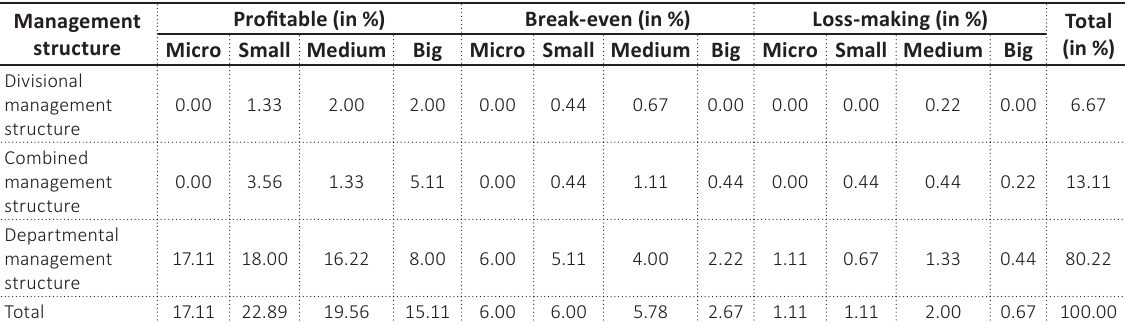
Table 5. Dependence between management organizational structure, size, and profitability of enterprises